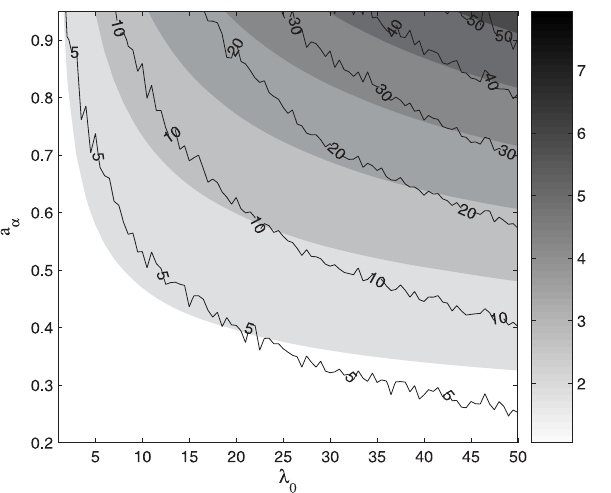
Fig. 2. Sensitivity of the return period R ( POT ) to variations of λ 0 T and a α , with T =100 years, δ = π , n =1 and a λ =0.5. In each point of the plane the intensity of the grey-shade is proportional to the value of the return period ratio R ( POT ) . The percentage of cases rec- T ognized as non-exponential by the Anderson-Darling test (at a 5% level) is indicated by the black (labelled) contour lines. N =20 years is considered.